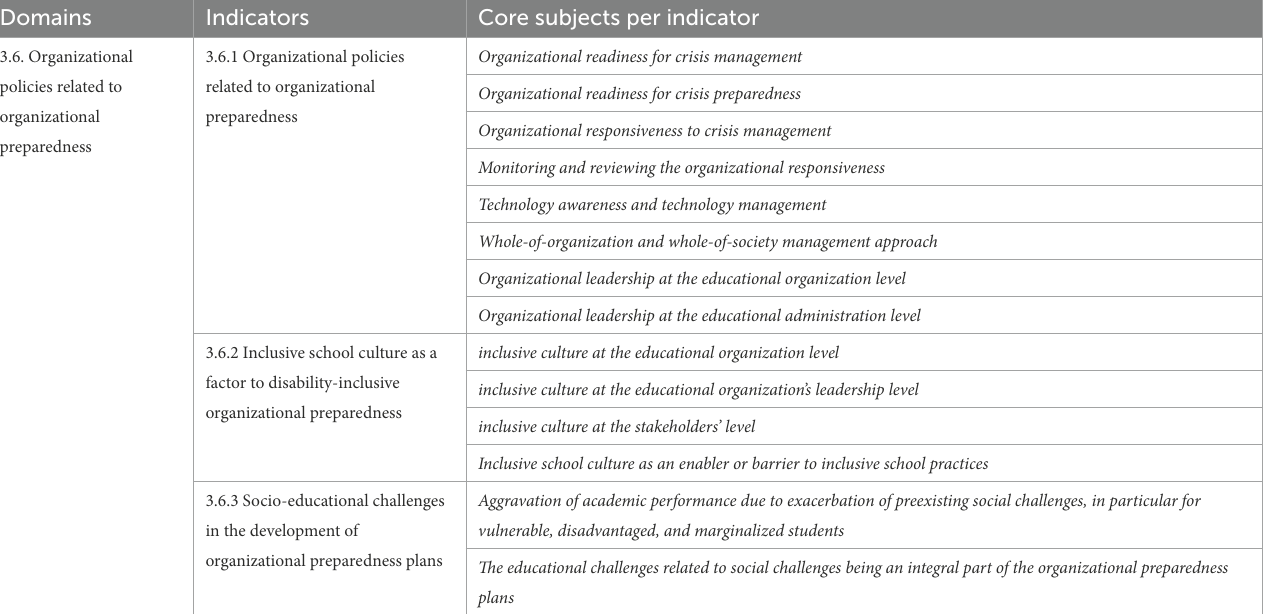
TABLE 7 Domain of organizational preparedness policies.